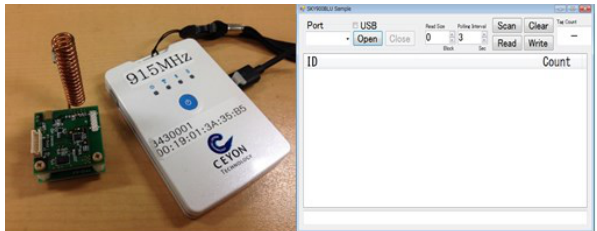
Figure 5. The measurement program used: UHF RFID reader/writer (CEYON SKY900BLE), and RF tag (NXP SL3S4011) attached to prototype wireless